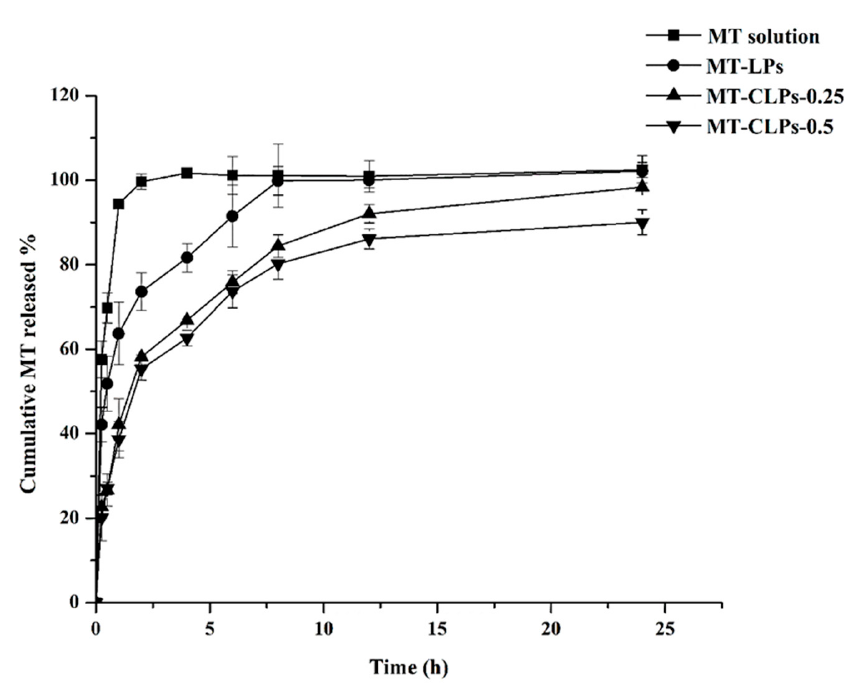
Figure 3. In vitro release profiles of MT-LPs, MT-CLPs-0.25, and MT-CLPs-0.5 (mean ± SD, n = 3).